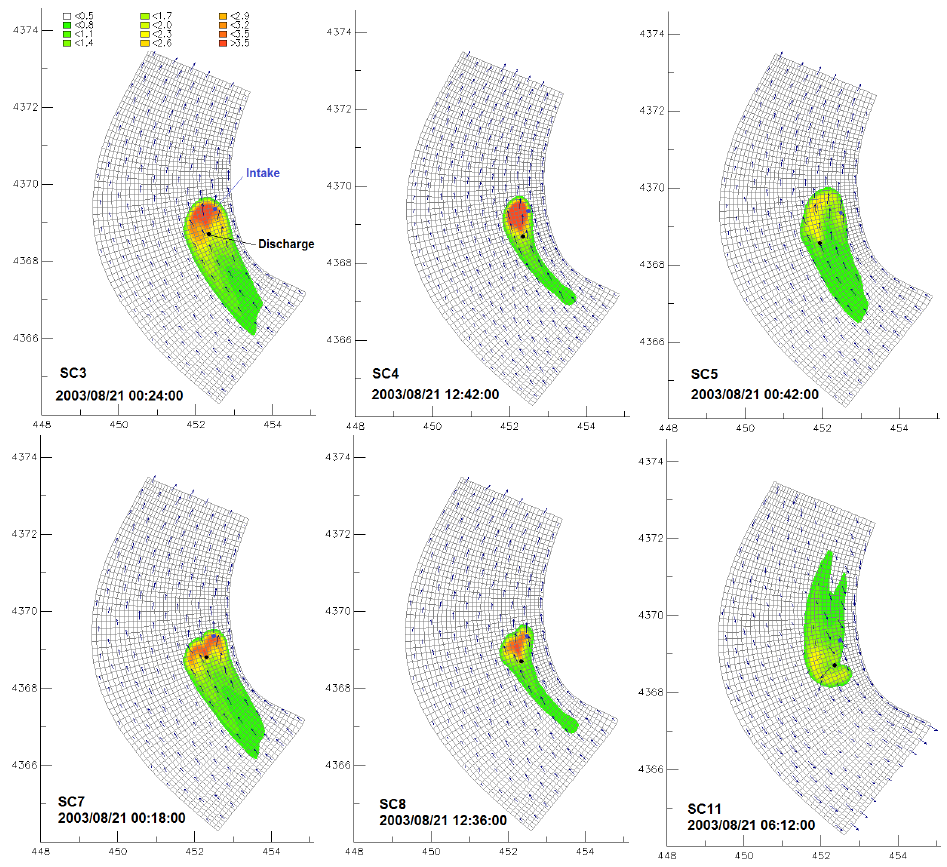
Figure 12. Maximum excess temperature: Scenarios 3, 4, 5, 7, 8 and